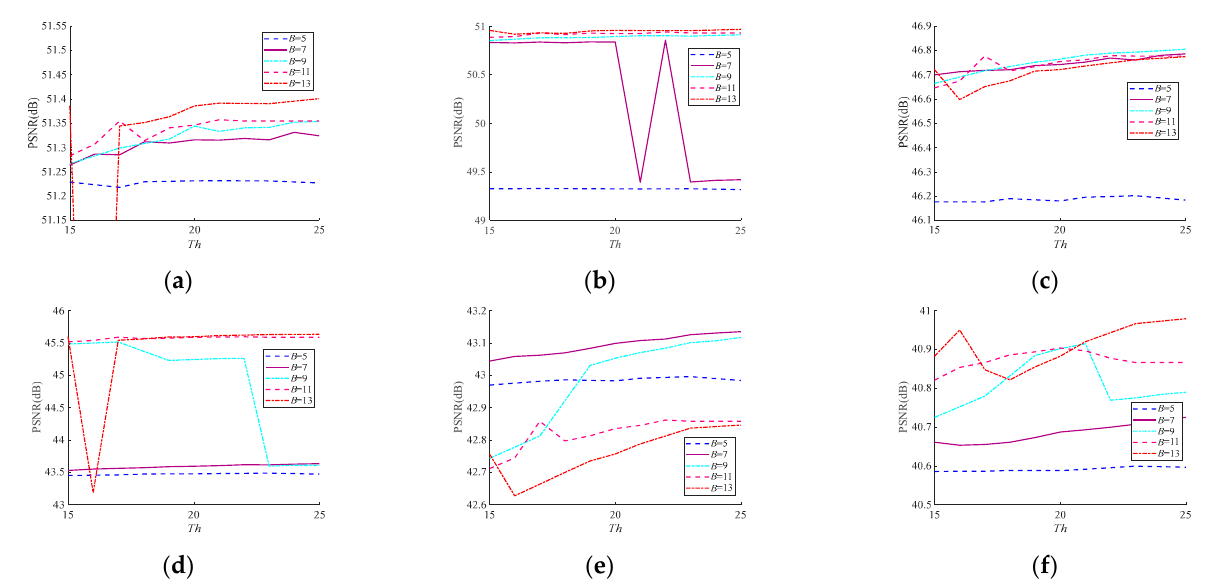
Figure 7. PSNR of different parameters for Lena: ( a ) PSNR under 0.1 bpp; ( b ) PSNR under 0.2 bpp; ( c ) PSNR under 0.3 bpp; ( d ) PSNR under 0.4 bpp; ( e ) PSNR under 0.5 bpp; and ( f ) PSNR under 0.6